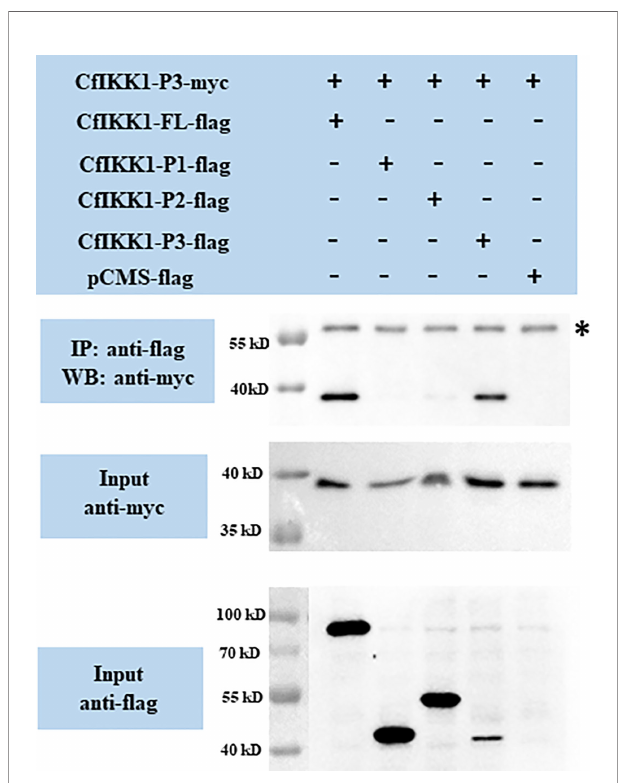
FIGURE 8 | Interaction between the CfIKK1 scaffold dimerization domain (CfIKK1-P3-myc) and various CfIKK1- fl ag proteins (CfIKK1-FL, CfIKK1-P1, CfIKK1-P2, and CfIKK1-P3), as veri fi ed using co-immunoprecipitation assays. CfIKK1-P3-myc was detected in the anti- fl ag immunoprecipitates of co- transfected (CfIKK1-FL and CfIKK1-P3) cell extracts, indicating the interaction of CfIKK1-P3-myc with CfIKK1-FL- fl ag and CfIKK1-P3- fl ag. Asterisk represents the heavy chain of mouse IgG. IP, co-immunoprecipitation assay; WB, western blot